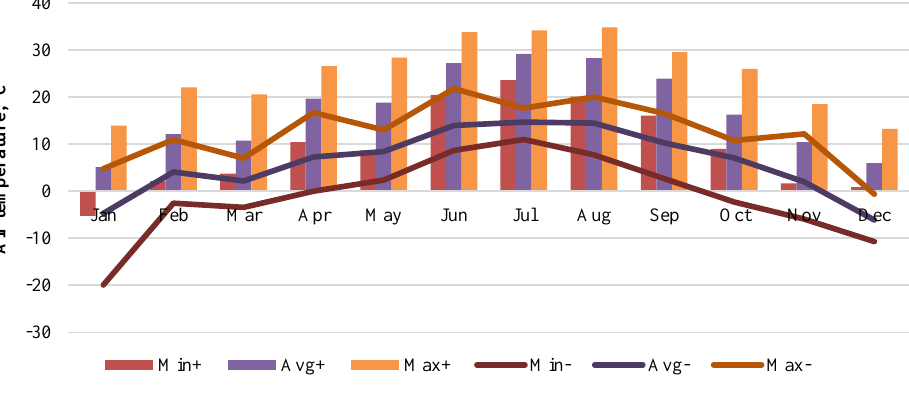
Fig. 3. Pristina. Max wind speed in Prishtina in 2016, m/s.